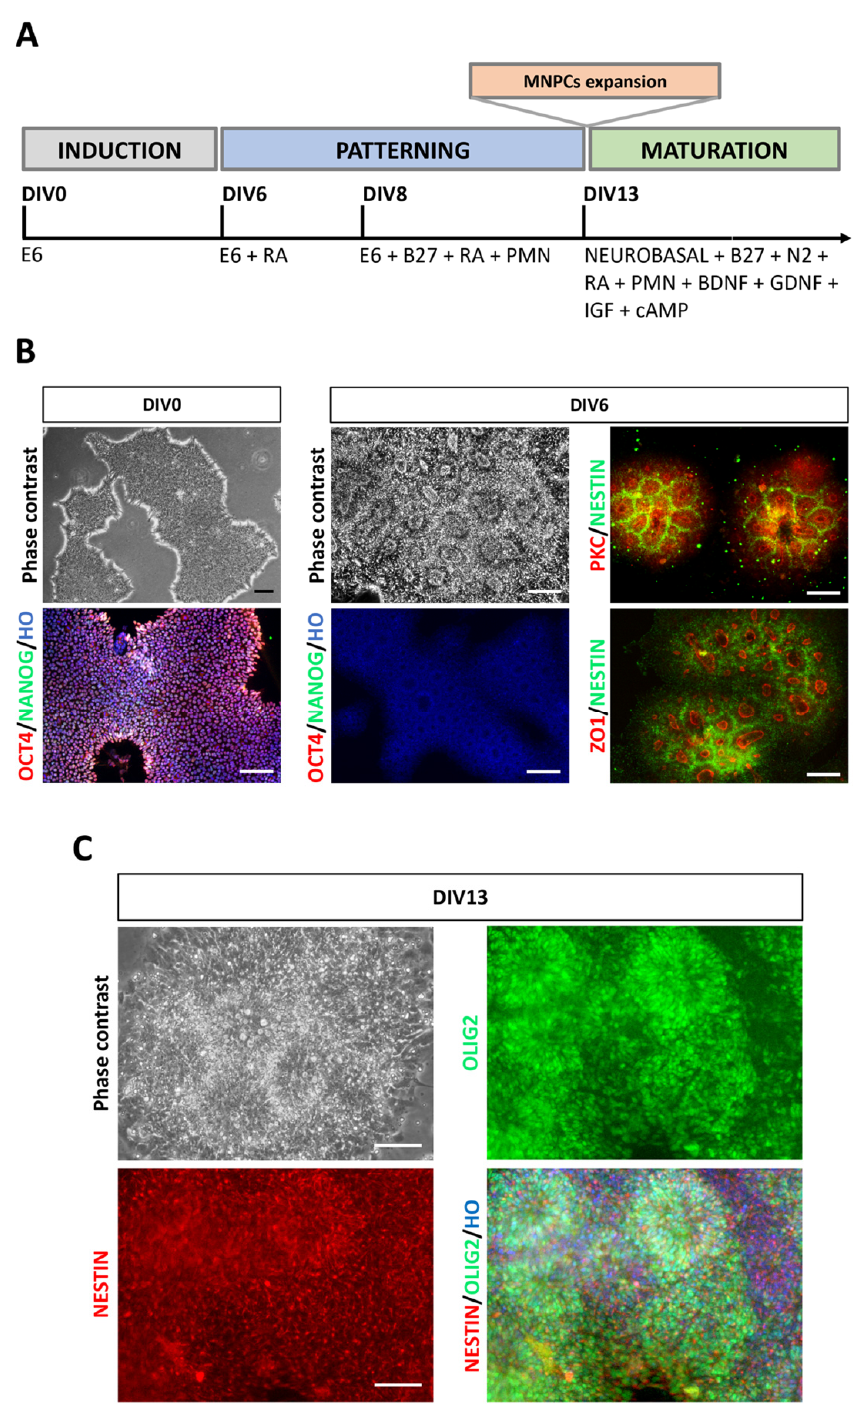
Figure 1. hiPSCs induction into MNPCs in monolayer conditions. ( A ) Schematic representation of MNPCs and MNs induction with all media and factors. ( B ) Representative pictures of the starting (DIV0) hiPSC cultures. At DIV6, cultures exhibit the formation of neural rosettes while showing lack of immunoreactivity for OCT4 and NANOG. These cultures instead show NESTIN immunoreactive signal together with PKC and ZO1 immunolabelling. Nuclei are stained with Hoechst (HO). ( C ) Contrast phase and immunofluorescence pictures of DIV13 cultures showing the presence of MNPCs immunoreactive for NESTIN and OLIG2; most of the cells are double positive for both markers. Nuclei are stained with Hoechst (HO). Scale bars: 100 μ m.